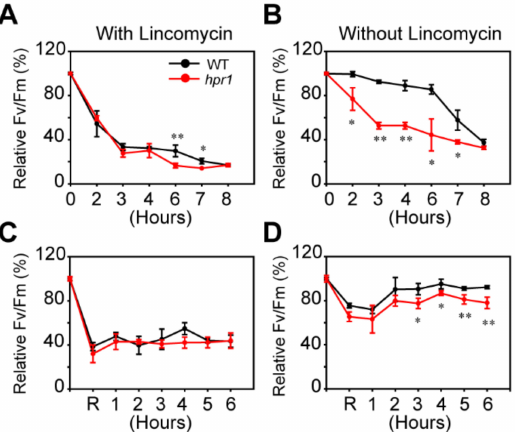
Figure 4. PSII photoinhibition analysis. ( A , B ) Photoinhibition of PSII in wild-type and hpr1 mu- tants was examined. Detached leaves from wild types and mutants were exposed to light at 1000 µ mol · m − 2 · s − 1 in the absence or presence of 1 mM lincomycin. The maximal photochemi- cal efficiency of PSII ( F v / F m ) was measured after dark adaptation for 15 min. Data shown are means ± SD, n = 3, with three independent replicates. Asterisks show significant differences compared to WT: * p < 0.05; ** p < 0.01 (Student’s t -test). ( C , D ) Recovery of F v / F m after photoinhibition in wild-types and hpr1 mutants. Detached leaves from wild types and mutants were exposed to light at 1000 µ mol · m − 2 · s − 1 in the absence or presence of 1 mM lincomycin until the PSII activity was reduced to 60%, and then subsequently, shifted to low light (60 µ mol · m − 2 · s − 1 ) to recover. Data shown are means ± SD, n = 3, with three independent replicates. Asterisks show significant differences compared to WT: * p < 0.05; ** p < 0.01 (Student’s t